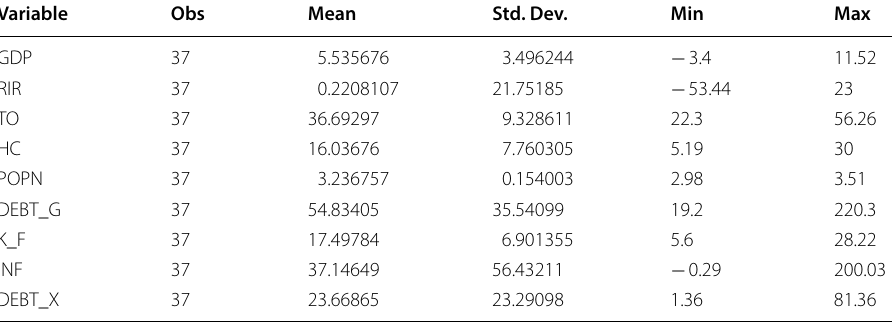
Table 2 Summary of descriptive statistics of the variables